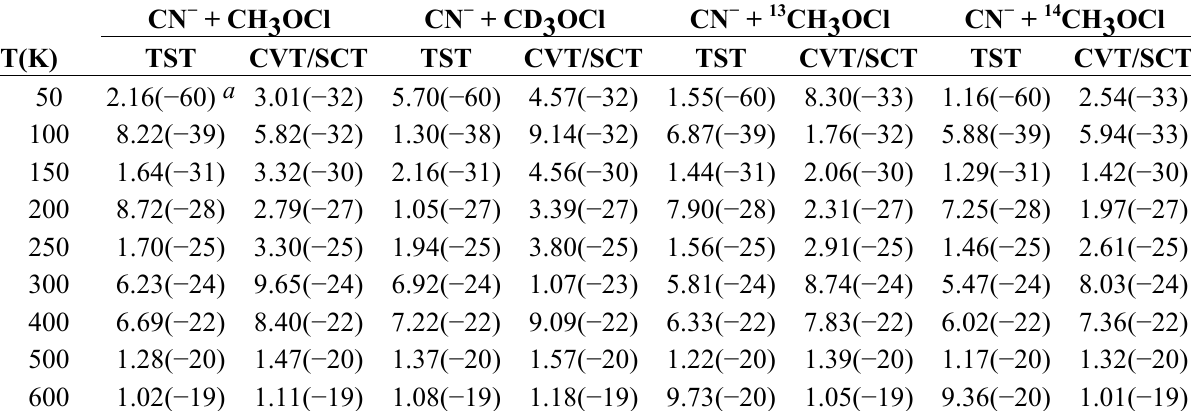
Table 8. Calculated rate constants (cm 3 molecule − 1 s − 1 ) by the TST and CVT/SCT methods.